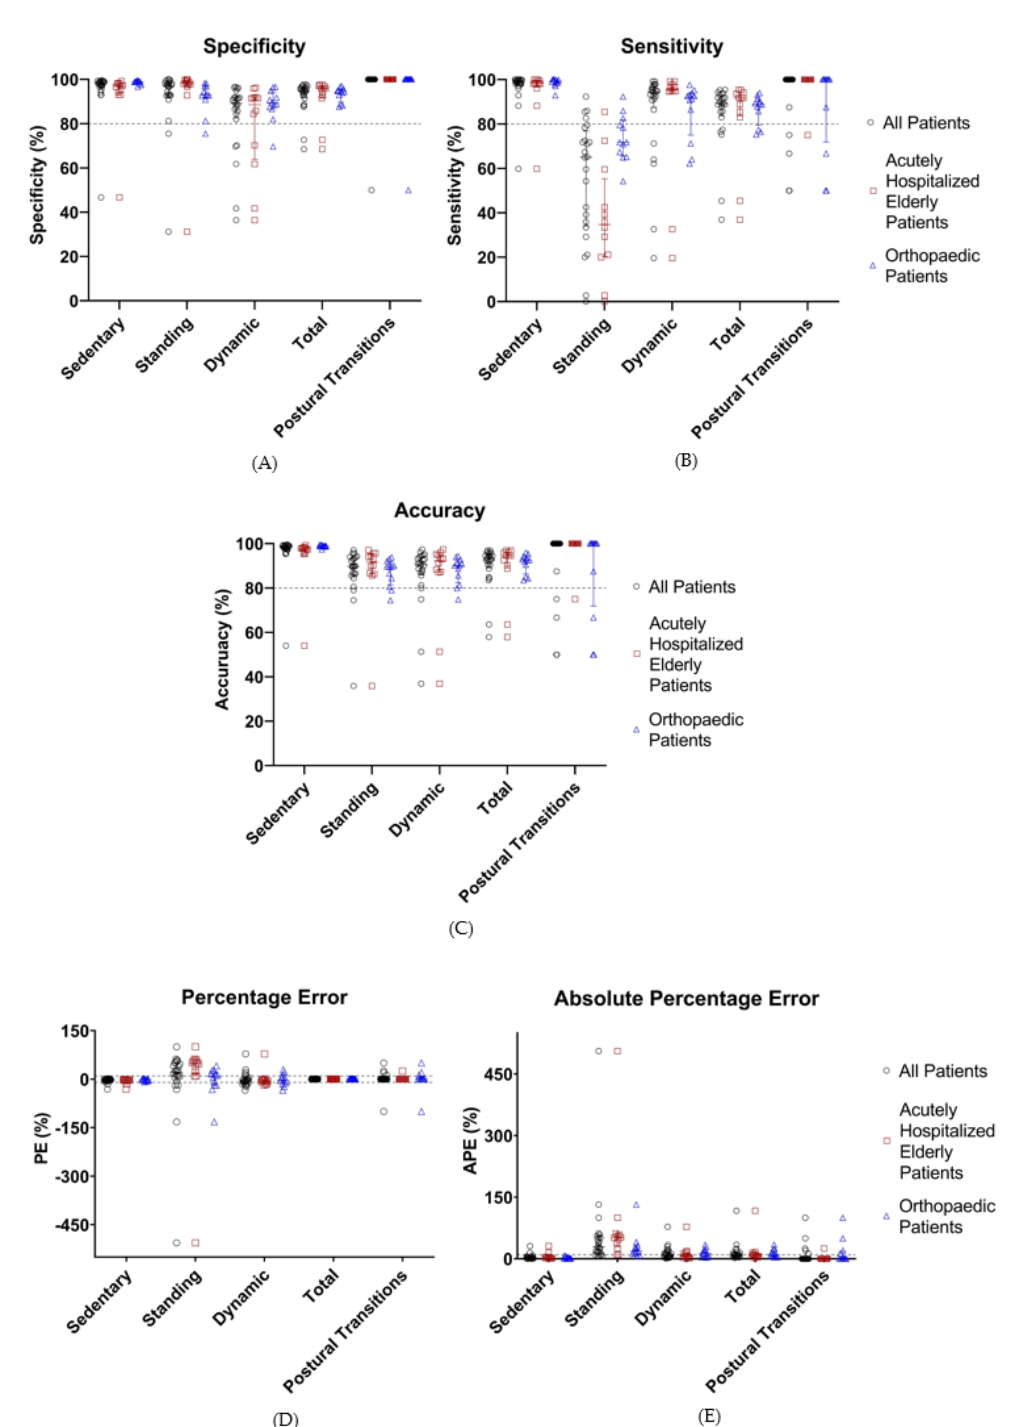
Figure 5. Performance metrics (%, sensitivity ( A ), specificity ( B ), accuracy ( C ), percentage error ( D ), and absolute percentage error ( E )) of the classification of activities by HFITAL within the validation group. All individual values are shown. Acceptable limits are represented by dashed lines. “All Patients” are represented in black, “Acutely Hospitalized Elderly Patients” in brown, and “Orthopedic Patients” in blue. (MOXAL = adjustable classification algorithm validated in community-dwelling healthy elderly persons with an upper leg wear location, used as the starting point for the optimization process. MOXAL Opt = classification algorithm after optimization of three adjustable parameter settings of MOXAL to reduce the absolute percentage error for total activity. HFITAL = classification algorithm after additional modifications were introduced to MOXAL regarding the decision tree and the calculation of the amount of physical activity).